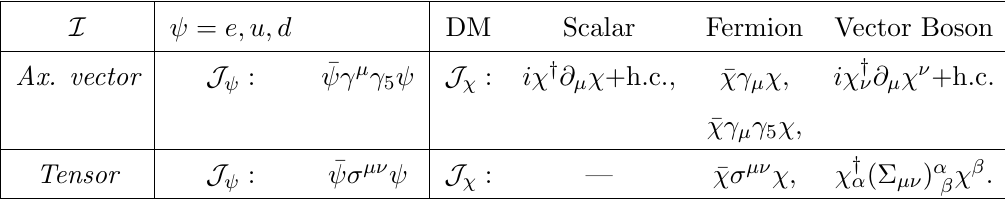
Table 1 . Leading interactions for scattering between DM and SM fermions in the form of operators of dimension 6. We only write operators that do not vanish in the limit of zero O (cid:17) J (cid:2) J (cid:31) (cid:20) transferred momenta. The terms (cid:27) (cid:22)(cid:23) = 2 (or ((cid:6) (cid:22)(cid:23) ) (cid:11) ) are the Lorentz generators in spin 1/2 (or spin (cid:12)